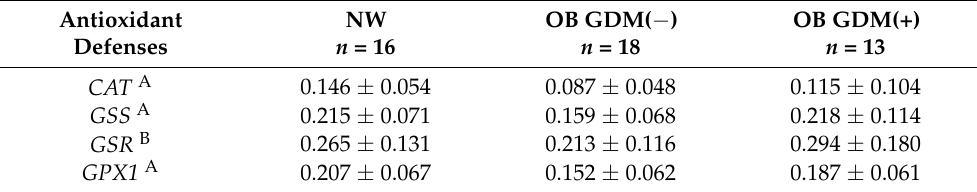
Table 4. Gene expression of antioxidant defense enzymes in placental tissue.